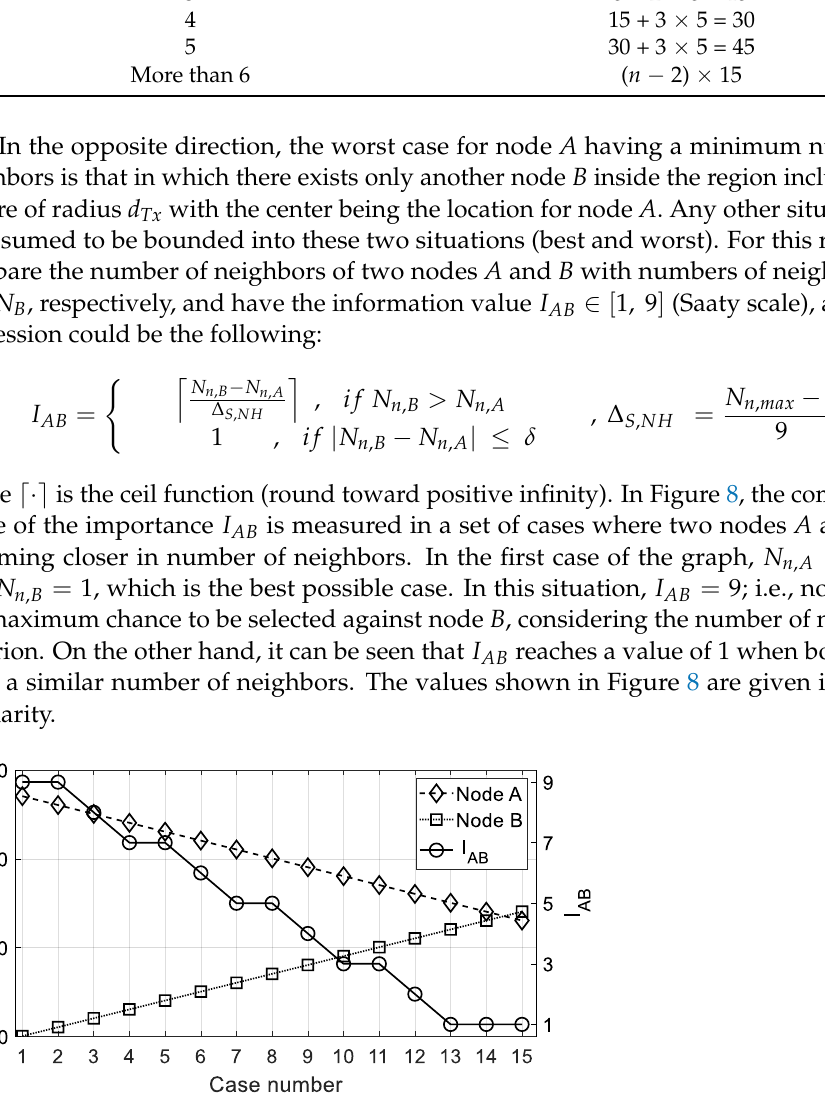
Figure 8. Importance value 𝐼 𝐴𝐵 when nodes A and B are compared under the number of neighbors Table 3. Information values from Figure 8 (number of neighbors